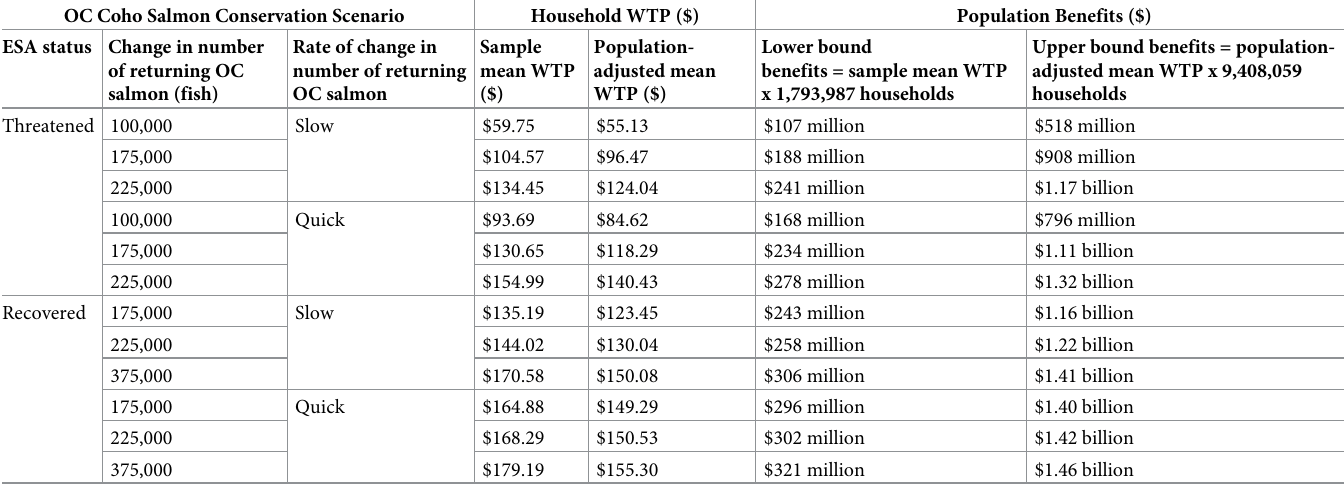
Table 3. Estimated annual mean household Willingness-to-Pay (WTP) and aggregate population benefits for Oregon Coast Coho Salmon conservation scenarios. OC Coho Salmon Conservation